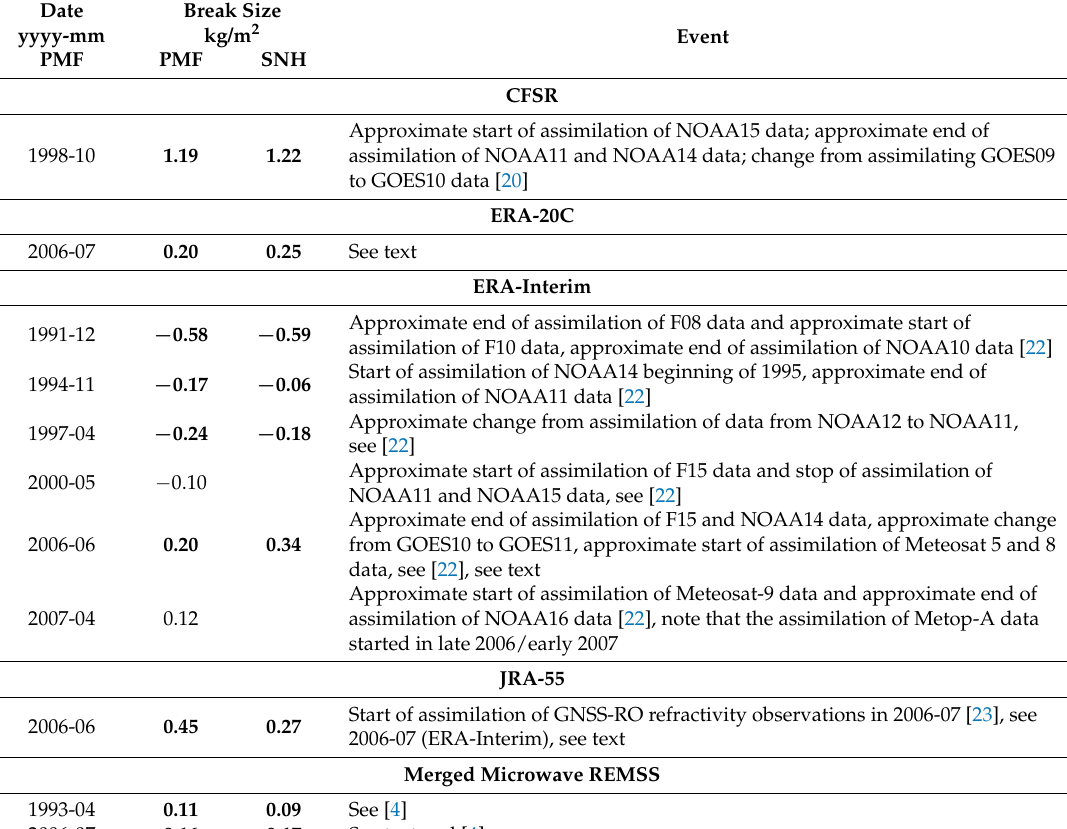
Table 2. Dates of observed break points, break sizes from the PMF test and coincident changes in the observing system or changes of the input to the assimilation schemes based on the analysis of TCWV anomaly differences relative to HOAPS for the global ice-free ocean within 60 ◦ N/S (extended and updated from [3,4]). Additionally, the break size from the SNH test is given when within a range of ± 3 month of the date of the break point from the PMF test. Here, all given break sizes from the SNH test are significant. The break size is printed in bold when the results from both homogeneity tests agree on the date. The information on the various events is partly taken from figures published in the literature. Information on the status of NOAA satellites was received from http://www.ospo.noaa. gov/Operations/POES/decommissioned.html and